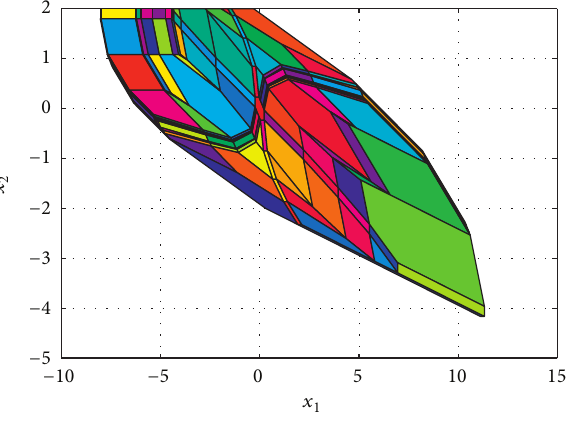
Figure 8: The partitions of feasible set X 3 3 ( 𝑁 = 3 ).